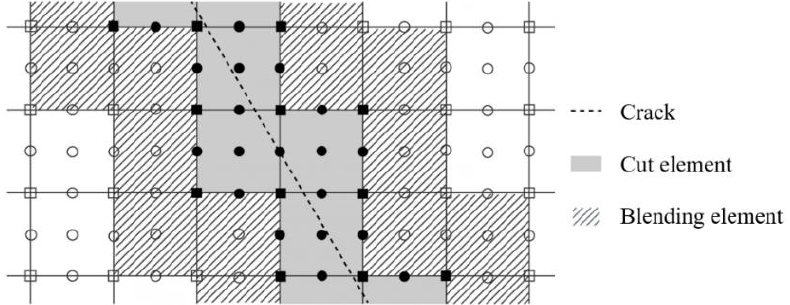
Figure 2. Cut element and blending element in the extended finite element method (XFEM).